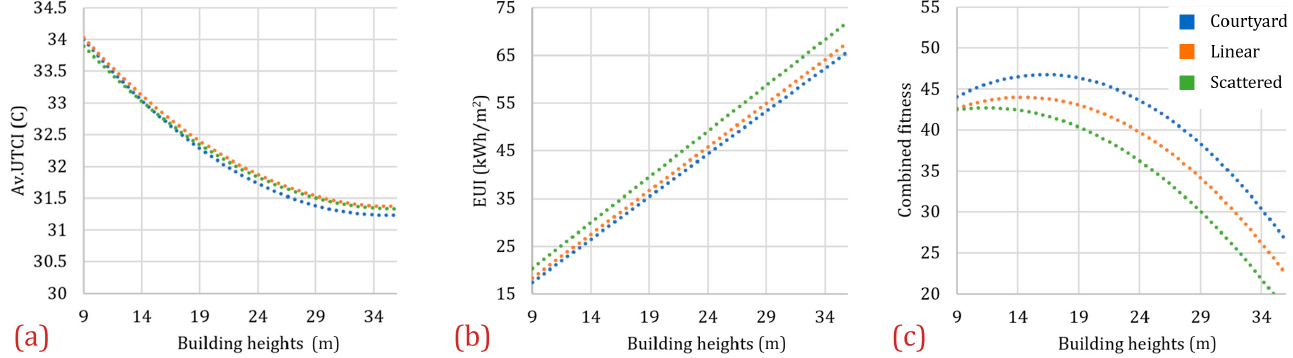
Figure 7. Trendlines of heights-based performance for the three typologies in terms of ( a ) AV.UTCI, ( b ) EUI, and ( c ) combined fitness.